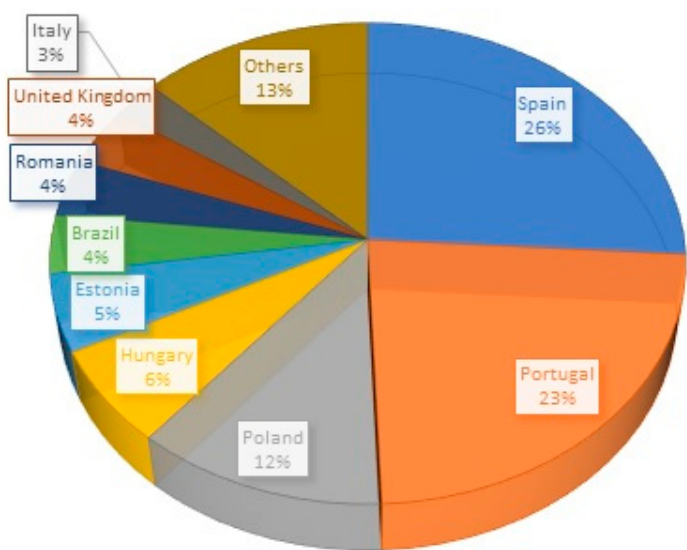
Figure 6. Countries of affiliation of the authors.